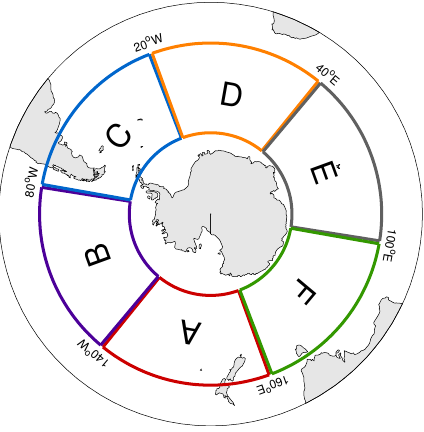
Figure 8. Polar stereo projection showing longitudinal sectors A–F in the latitude band 40–65 ◦ S used in Fig.